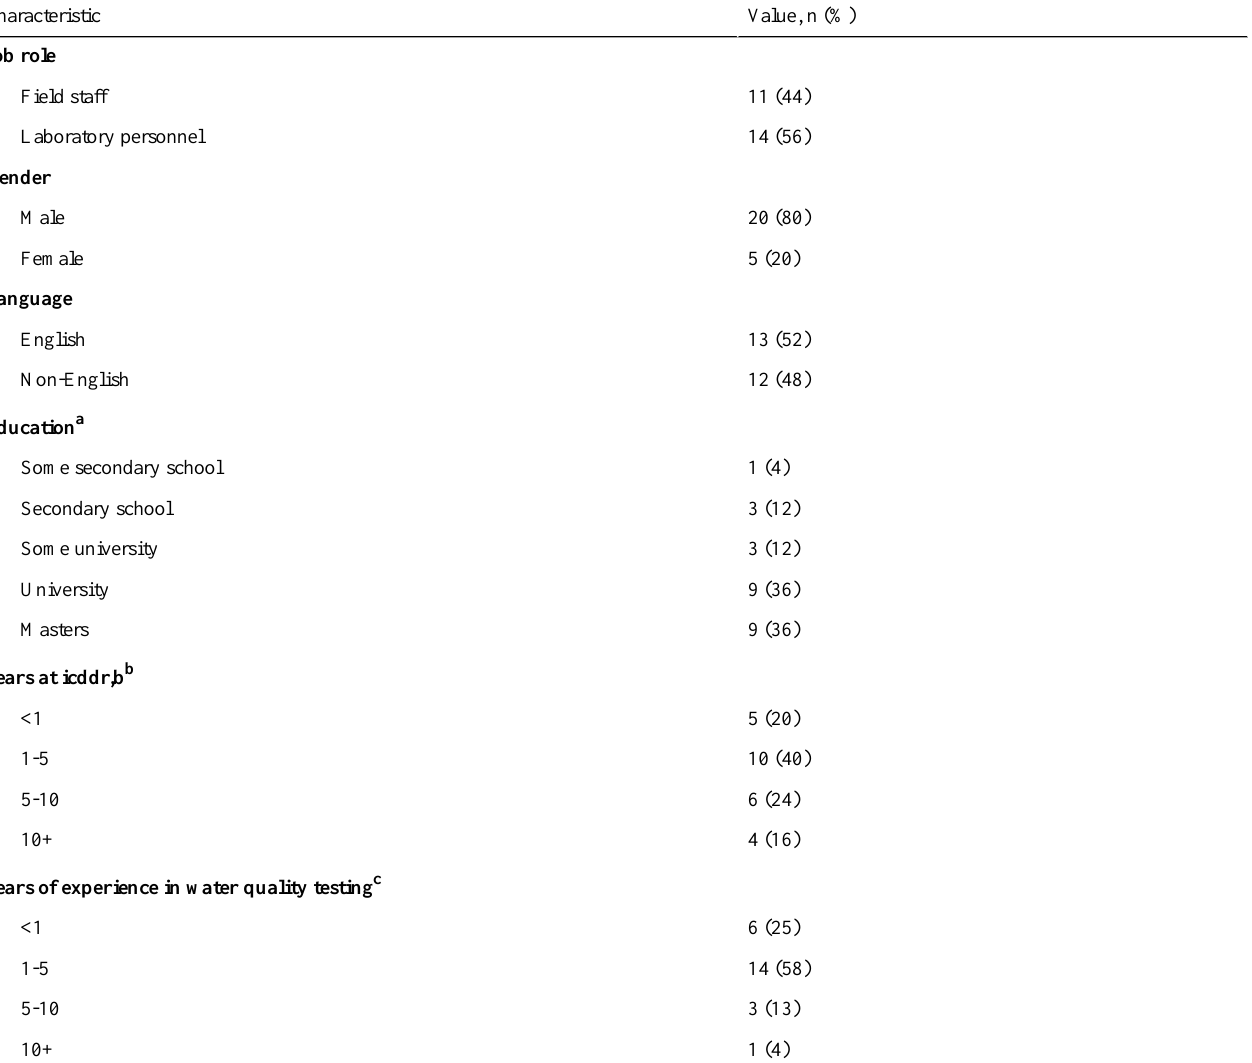
Table 1. Participant demographics